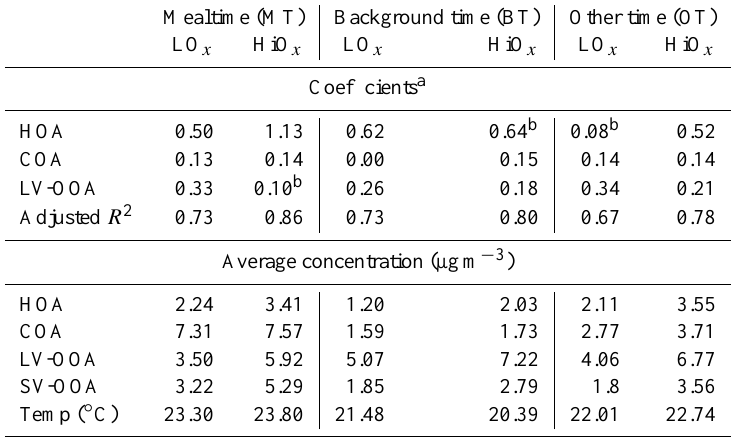
Table 3. Regression of SV-OOA on HOA, COA and LV-OOA and concentrations of OA factors and temperature under high and low O x (HiO x and LO x ) of four chosen periods (MT, BT and OT).